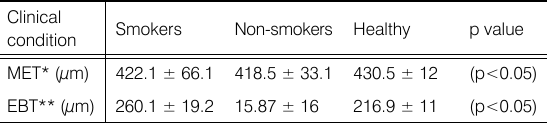
Table 2. Major epithelial thickness and epithelial base thickness, expressed in µm